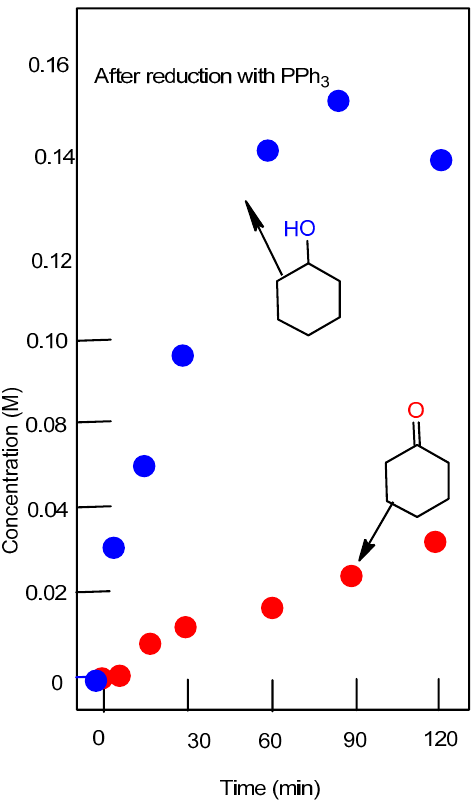
Figure 4. Accumulation of cyclohexanol and cyclohexanone in the oxidation of cyclohexane (0.46 M) with H 2 O 2 (2.0 M) catalyzed by complex 1 (5 × 10 − 4 M) in the presence of PCA, at 50 ◦ C in acetonitrile. Concentrations of products were measured by GC after the reduction of the reaction samples with solid PPh 3